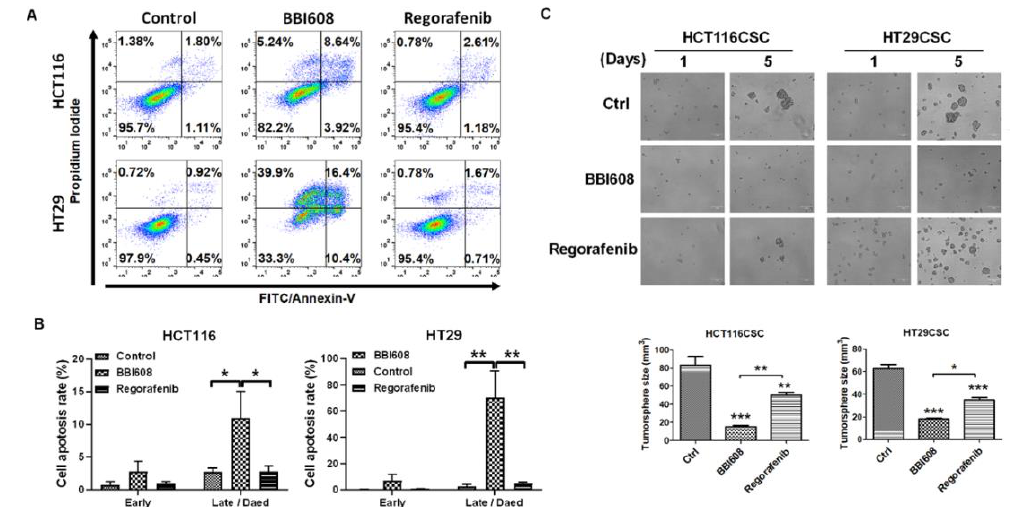
Figure 2. STAT3 inhibitor BBI608 prevented CRC-derived tumorspheres formation. ( A ) BBI608 induced stronger apoptotic effects than regorafenib in HCT116 and HT29 cells. ( B ) Quantification of apoptosis. ( C ) BBI608 significantly reduced the sizes of HCT116- and HT29-derived tumorspheres compared with controls or regorafenib-treated cells. Each IC50 concentration of BBI608 and regorafenib was used for detecting apoptosis and tumorsphere formation. Bar scale: 100 μm. * p < 0.01, ** p < 0.01, *** p < 0.001.